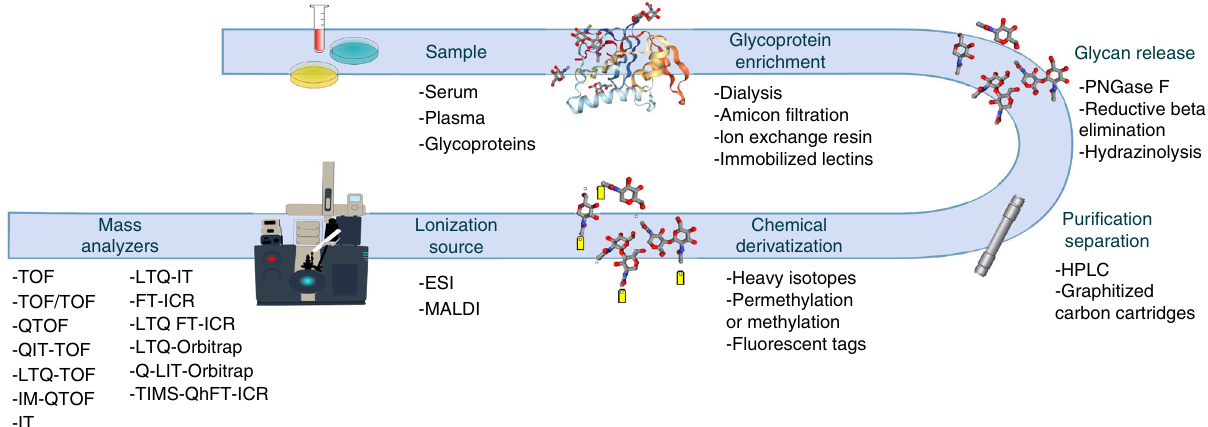
Fig. 1 General Overview of a glycomics MS work fl ow. The analytical options at each step are shown below. A similar work fl ow has been described in ref. 19 . TOF time of fl ight mass analyzer, TOF/TOF TOF tandem MS, Q quadrupole mass analyzer, QTOF tandem MS combining Q and TOF, IT ion trap mass analyzer, QIT dual operational Q and IT MS, QIT-TOF QIT combined with TOF tandem MS; LTQ(-IT), linear trap quadrupole mass analyser (a linear ion trap), LTQ-TOF tandem MS combining LTQ and TOF, IM ion mobility, IM-QTOF ion mobility cell/QTOF mass spectrometer, FT-ICR Fourier-transform ion cyclotron resonance mass analyzer, LTQ FT-ICR tandem MS combining LTQ and FT-ICR, LTQ-Orbitrap tandem MS combining LTQ and Orbitrap, LIT linear ion trap, Qh quadrupole/hexapole interface, TIMS trapped ion mobility